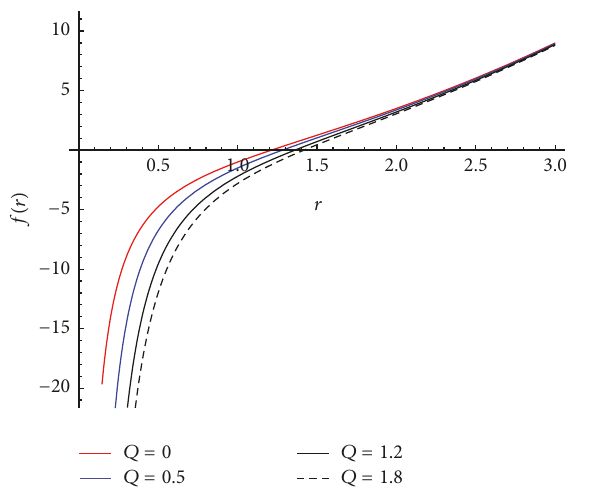
Figure 1: The figure shows 𝑓(𝑟) versus 𝑟 for 𝛾 = 1 for varying 𝑄 . Here 𝜆 = 2.4 , Λ = −3 , and 𝑀 = 1.5 .